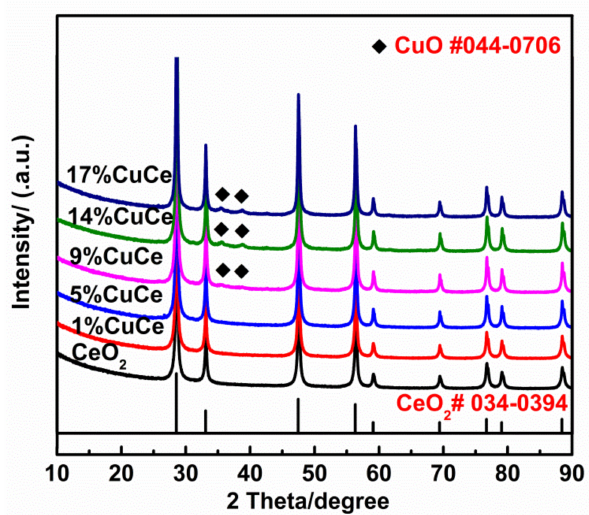
Figure 1. X-ray diffraction (XRD) patterns of the prepared